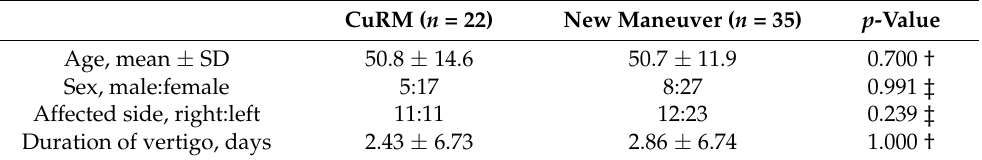
Table 1. Subject characteristics ( n =